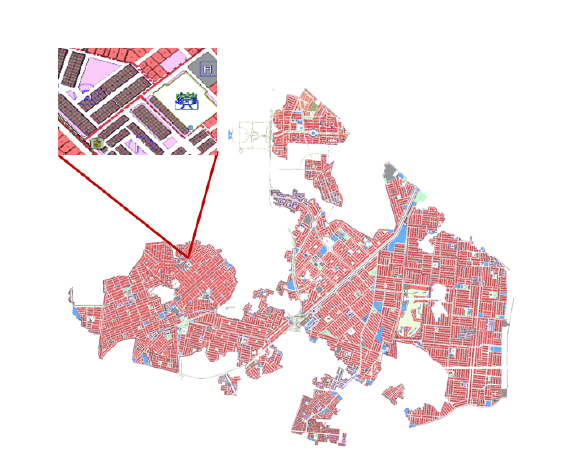
Figure 4. Extracting Geo-Locations. An example of one of the geo-referenced digitized map, along with the extraction of center points using raster to vector and other GIS